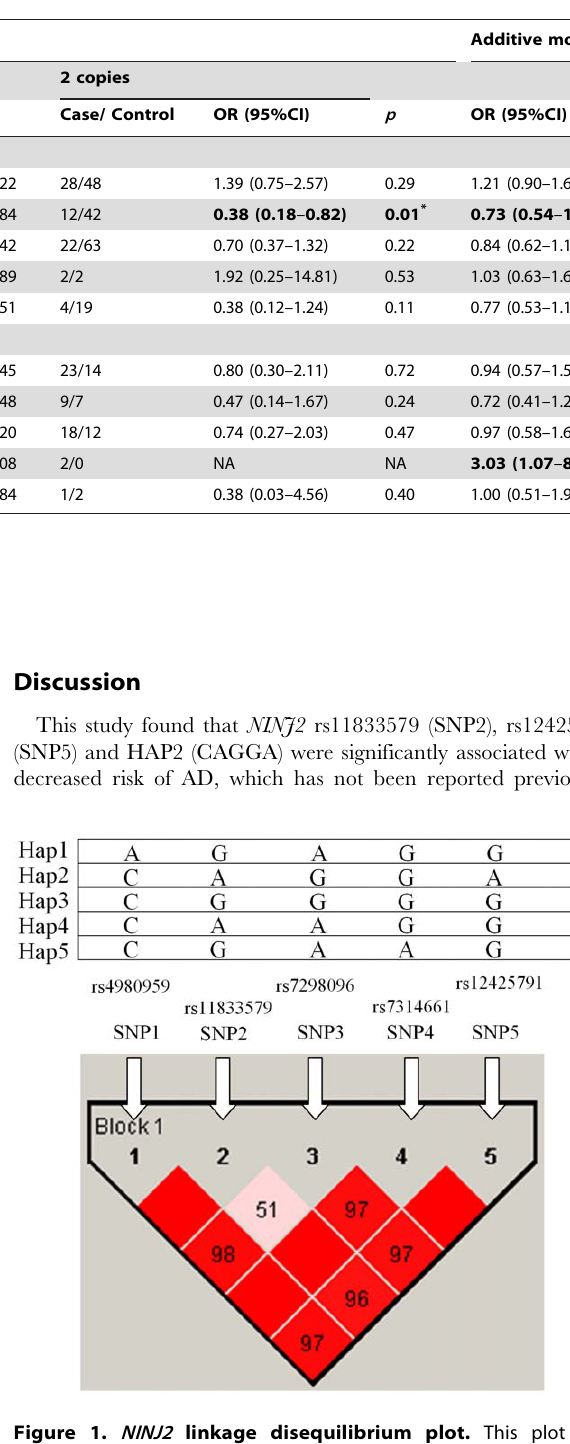
Co-dominant model